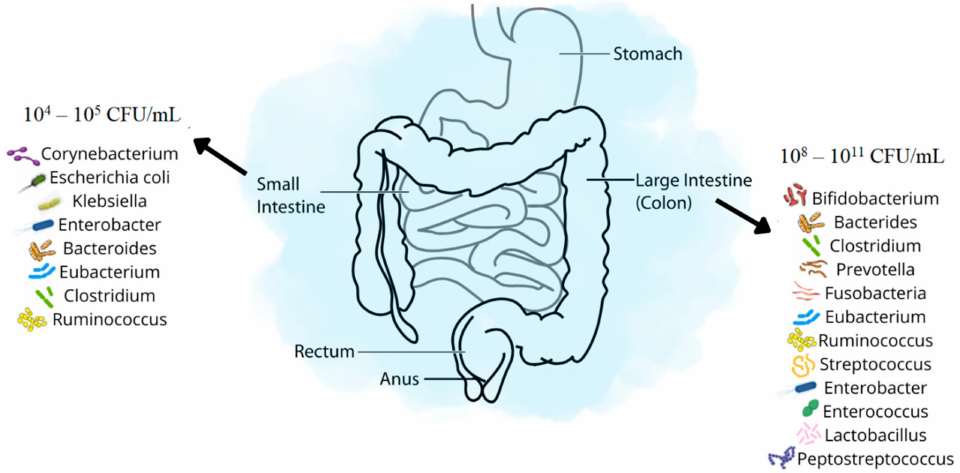
Figure 1. Distribution of particular types of bacteria in the digestive system (based on [3,4,6]). As mentioned above, the microbiome primarily consists of bacteria, viruses and fungi. The 160 or so species of microorganisms include Firmicutes , Actinobacteria , Pseudomon- adota , Fusobacteria and Verrucomicrobia . Firmicutes and Bacteroidetes bacteria phyla dominate and make up 90% of the human gut microbiota. Over 200 different genera of bacteria represent the Firmicutes phylum . These include Lactobacillus , Clostridium , Enterococcus and Ruminococcus . The Bacteroidetes phylum is mainly characterized by the Bacteroides and Prevotella genera